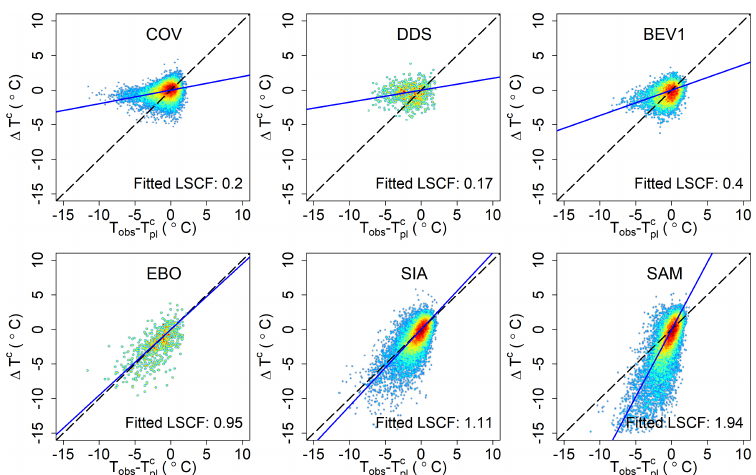
Figure 7. Difference of observed temperature and a prediction involving pressure levels ( T obs − T f smoothed color density of a scatter plot to make a quantity of points visual. The lines are results of LSCF × (cid:49)T c by using LSCF of 1 (black dash) and best-fitted LSCF (blue solid) at the selected stations. The time periods of the stations are presented in Table 3.